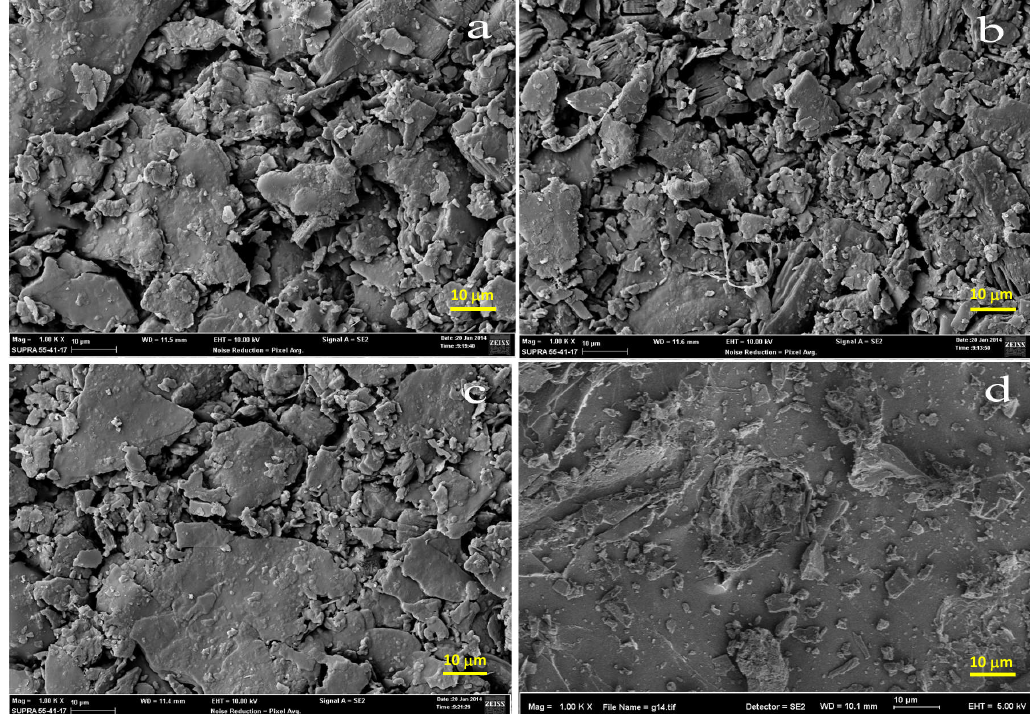
Figure 6. Fractured surfaces of fired clay for sintering temperatures of ( a ) 900 °C, ( b ) 1000 °C, ( c ) 1100 °C, and ( d ) 1200 °C.